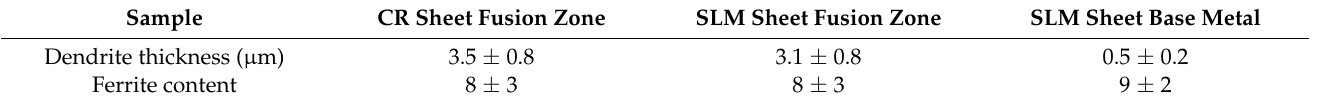
Table 7. Dendrite thickness and ferrite content of the fusion zone and SLM base metal. Sample CR Sheet Fusion Zone SLM Sheet Fusion Zone